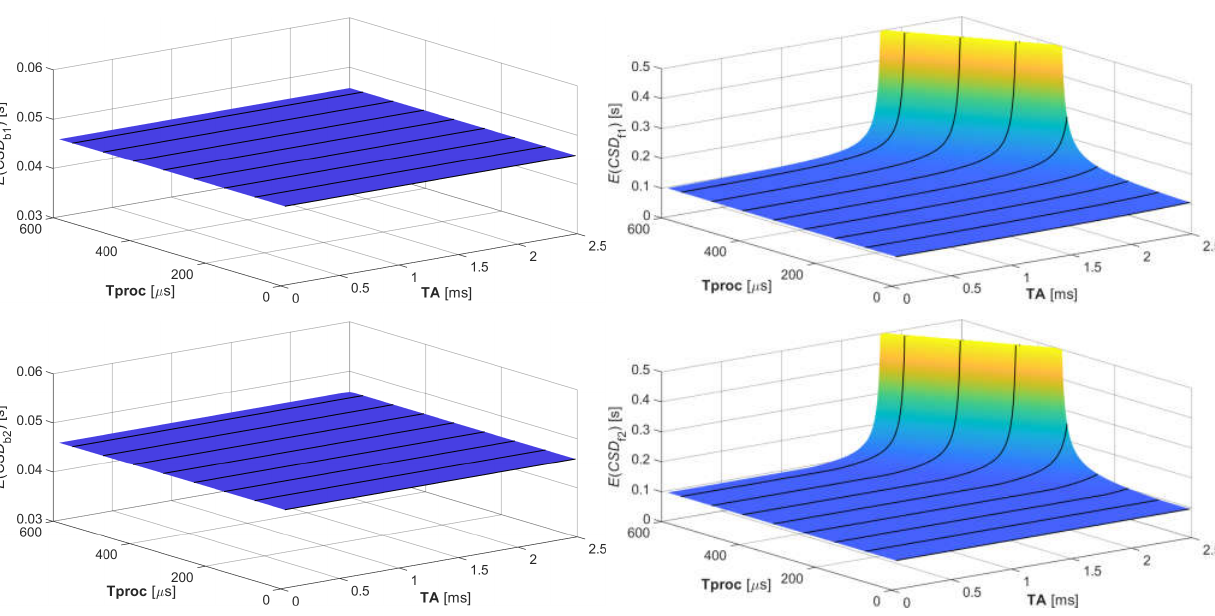
Figure 6. Selected results for data set 3 from Table 1.